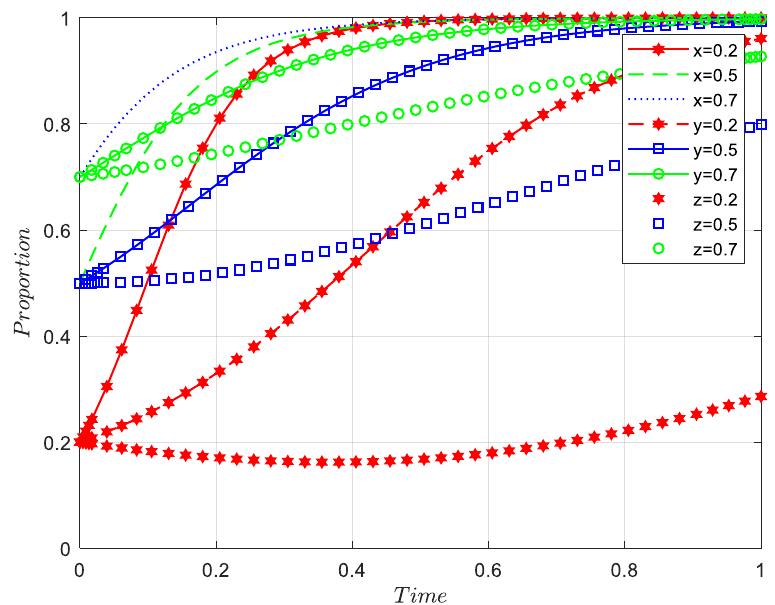
Figure 4. Before a public health emergency, the government regulatory agencies–SMEs–consumers (Two-dimensional graph).